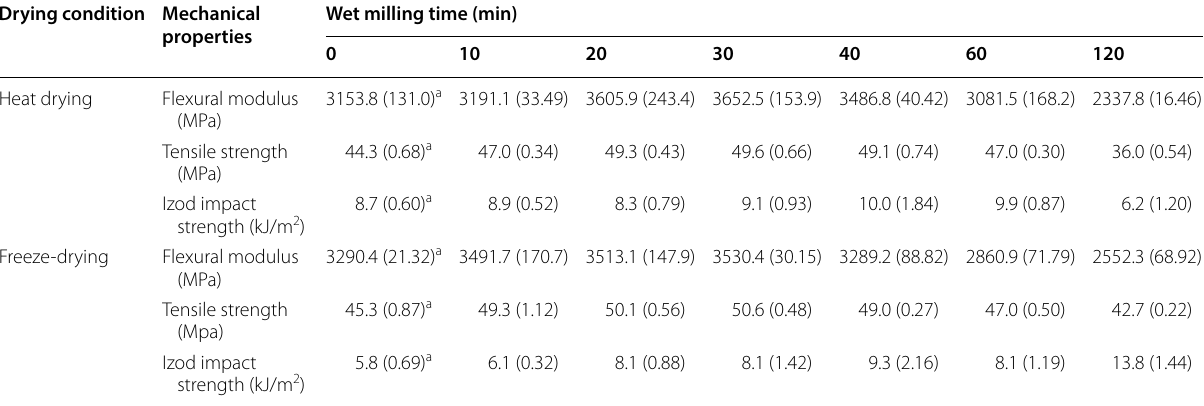
Table 3 The mechanical properties of WPC for each condition